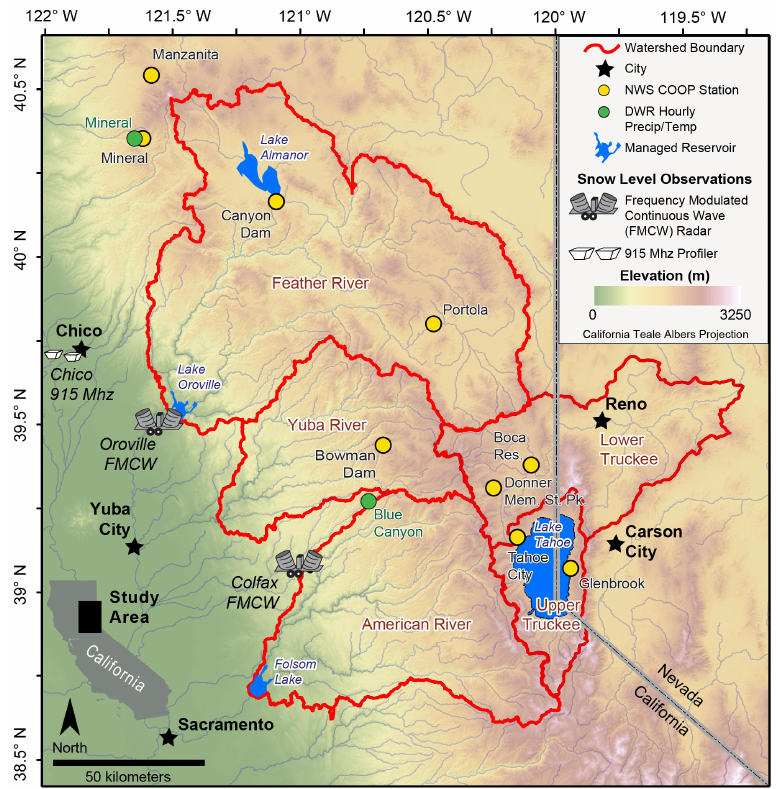
Figure 1. The northern Sierra Nevada study area.